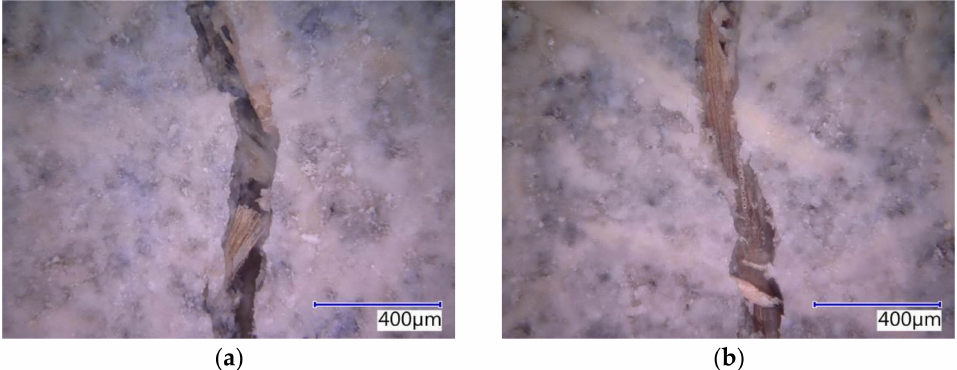
Figure 26. Detailed structure of crack Ce-M20—pictures from optical microscope: ( a ) chip pulled out from the matrix; ( b ) chip oriented along with the crack pulled out from the